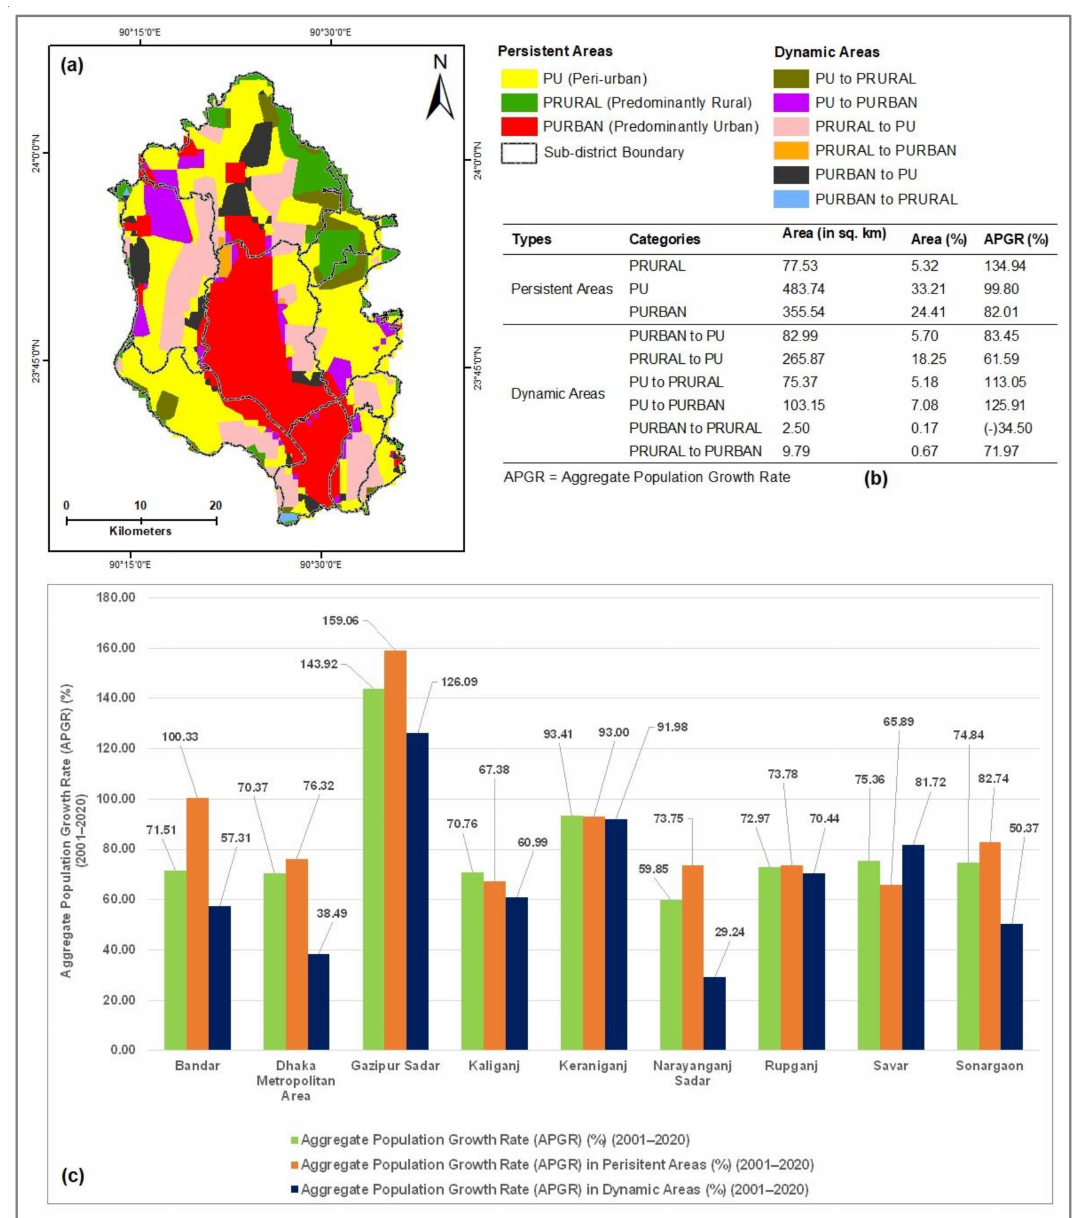
Figure 18. ( a ) Map showing the spatial distribution of predominantly rural (PRURAL), peri-urban (PU), and predominantly urban (PURBAN) areas; ( b ) table showing percentage distribution in the changes of PRURAL, PU, and PURBAN areas and corresponding changes in the aggregate population growth rate (APGR) between 2001 and 2020; ( c ) sub-district-wise aggregate population growth rate (APGR) between 2001 and